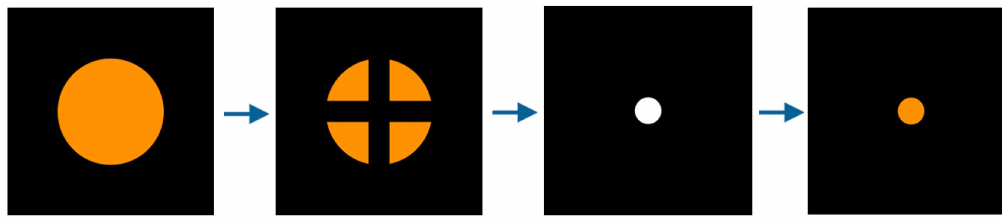
Figure 14. Guiding display method: ( a ) an expression guiding to the next marker position of the calibration, and ( b ) an example of a marker’s movement path.